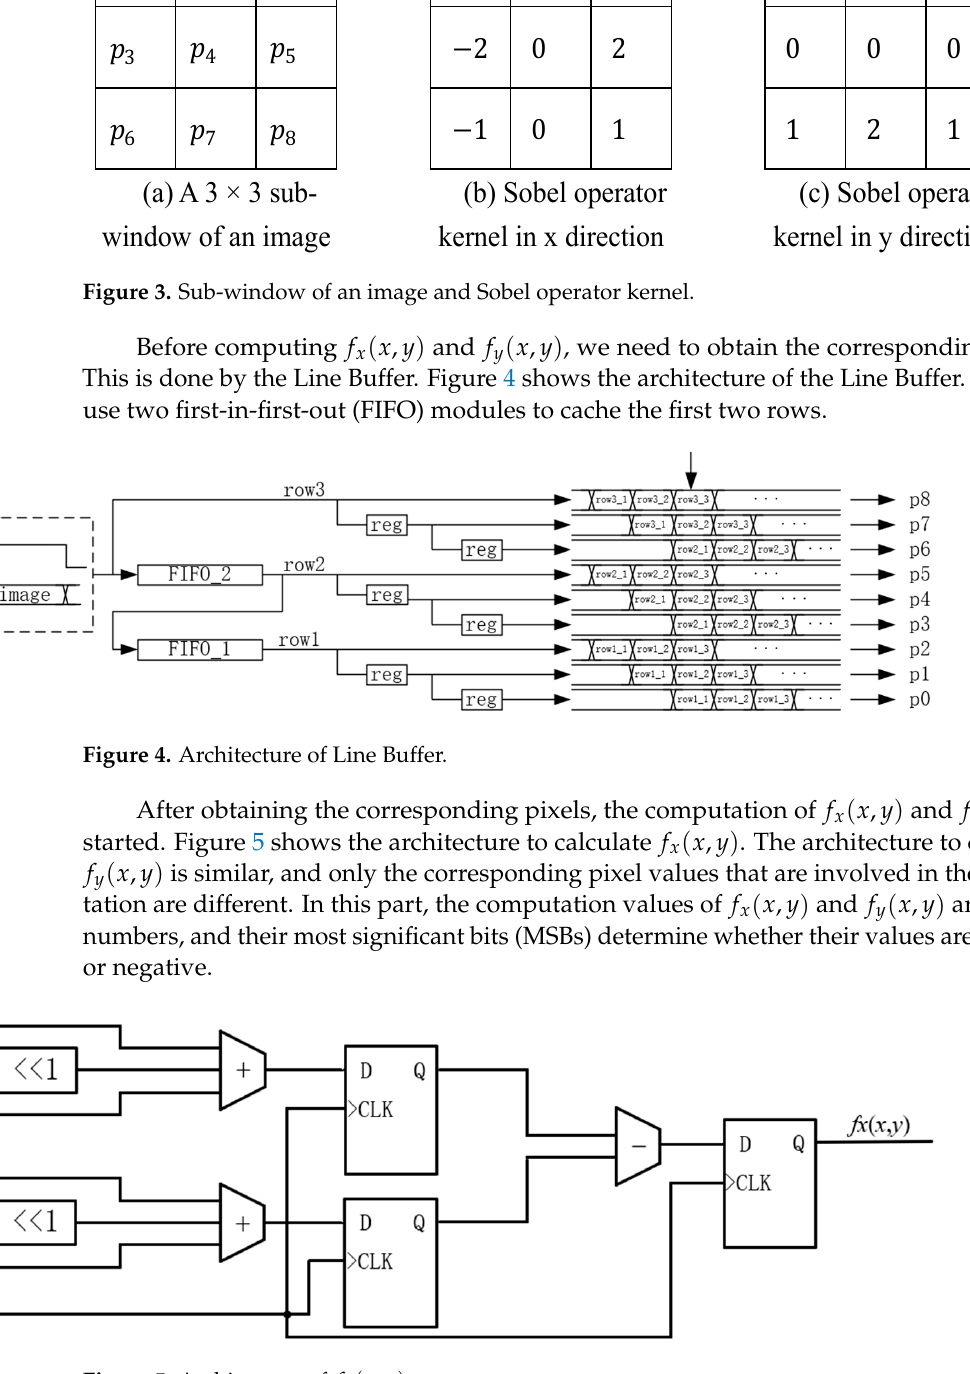
Figure 5. Architecture of f x ( x , y ) .